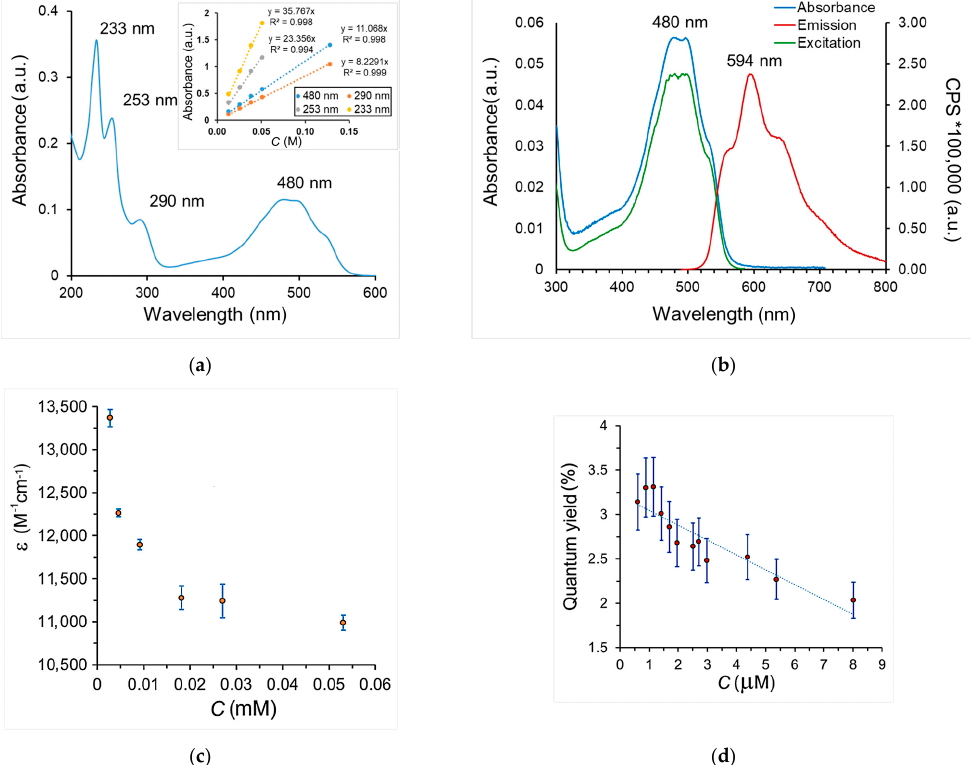
Figure 5. ( a ) Dox absorption spectrum; the inset shows a calibration plot for determination of the extinction coefficient ( ε Dox ) at wavelengths of 480, 290, 253, and 233 nm vs. concentration. ( b ) Ab- sorption, excitation and emission spectra. ( c ) Dependence of ε Dox (at 480 nm) on Dox concentration. Data are presented as M ± SD . ( d ) Concentration dependence of the relative quantum yield of Dox fluorescence (quantum yield (±10%) was determined relative to fluorescein in 0.1 M KOH as a standard ( ϕ = 0.85, λ ex = 470 nm)). Data are presented as M ± SD. When quantifying the Dox content by UV spectrometry, at first we experimentally determined the molecular extinction coefficient ( ε ) of Dox. To do this, the calibration curves of the optical density vs. the Dox concentration were plotted in the range of ab- sorbance ( A ) of 0.2–1.0 a.u. (see Supplementary Materials, Figures S4b,c). At a concentra- tion below 0.011 mM, the shoulder at 480 nm increases and the contribution of the band at 493 nm decreases (Figure S4d). In most cases, researchers rely on the values ε = 10,067– 11,500 M − 1 cm − 1 [93–95].